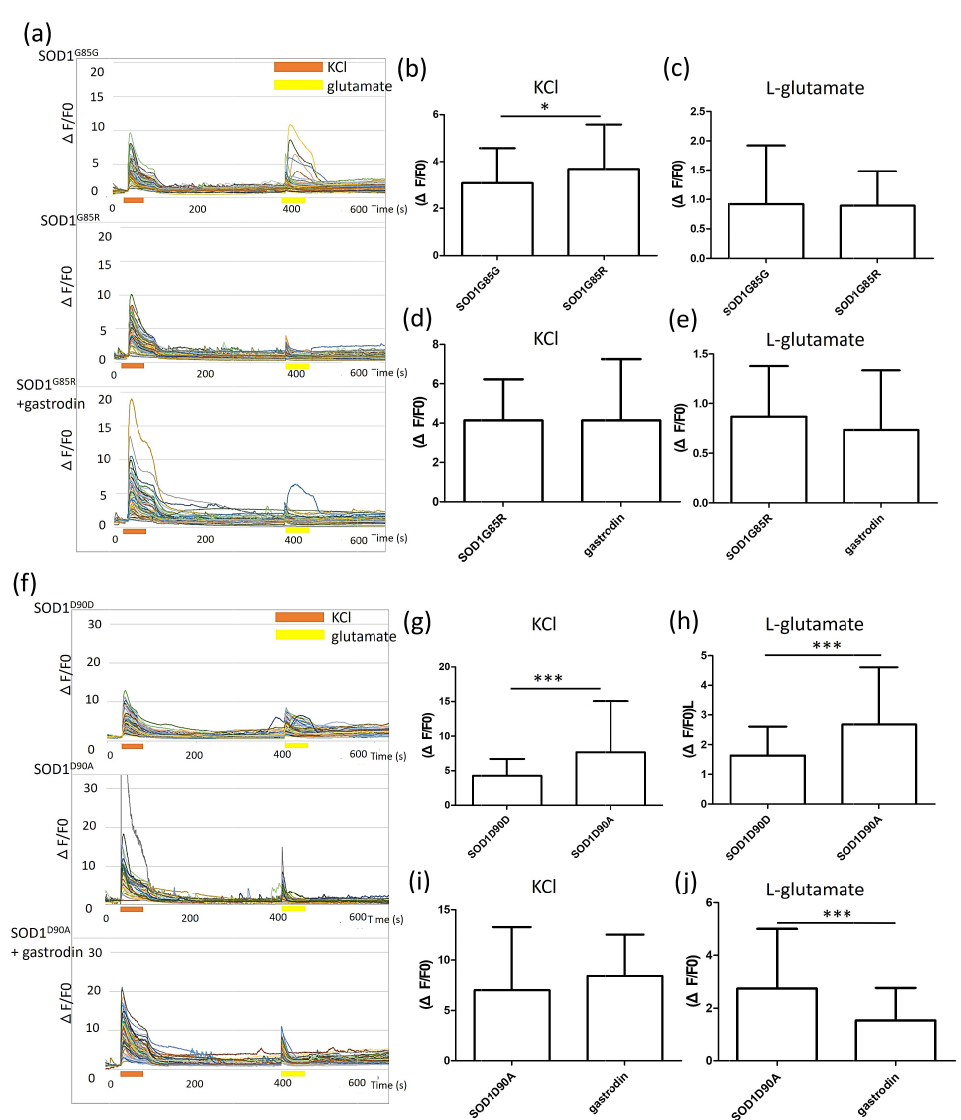
Figure 5. Gastrodin reverses SOD1 D90A MN hyper-calcium flux after glutamate stimulation. ( a ) SOD1 G85G , SOD1 G85R , and gastrodin-treated SOD1 G85R MNs were subjected to Fluo-4 calcium imaging at day 38 of differentiation. The calcium flux stimulated by potassium chloride (presented as orange bars) and glutamate (yellow bars) was revealed with ∆ F/F0. ( b , c ) Average calcium flux stim- ulated by potassium chloride ( b ) and glutamate ( c ) of SOD1 G85G and SOD1 G85R MNs. ( d , e ) Average calcium flux stimulated by potassium chloride ( d ) and glutamate ( e ) of untreated and gastrodin- treated SOD1 G85R MNs. ( f ) SOD1 D90D , SOD1 D90A , and gastrodin-treated SOD1 D90A MNs were subjected to calcium imaging. ( g , h ) Average calcium flux stimulated by potassium chloride ( g ) and glutamate ( h ) of SOD1 D90D and SOD1 D90A MNs. ( i , j ) Average calcium flux stimulated by potas- sium chloride ( i ) and glutamate ( j ) of untreated and gastrodin-treated SOD1 D90A MNs. * p < 0.05, *** p <